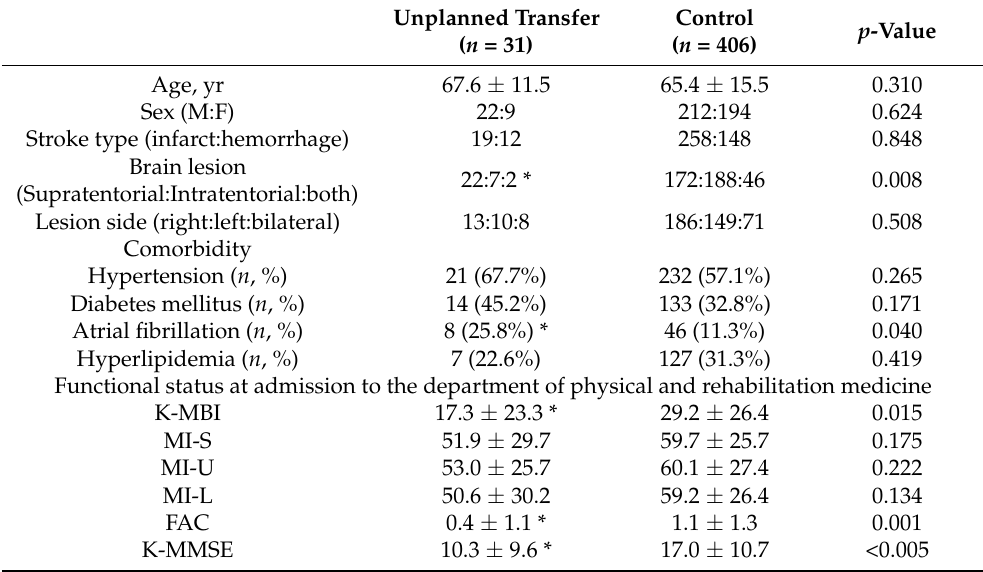
Table 4. Comparison between the unplanned transfer group and the control group in stroke